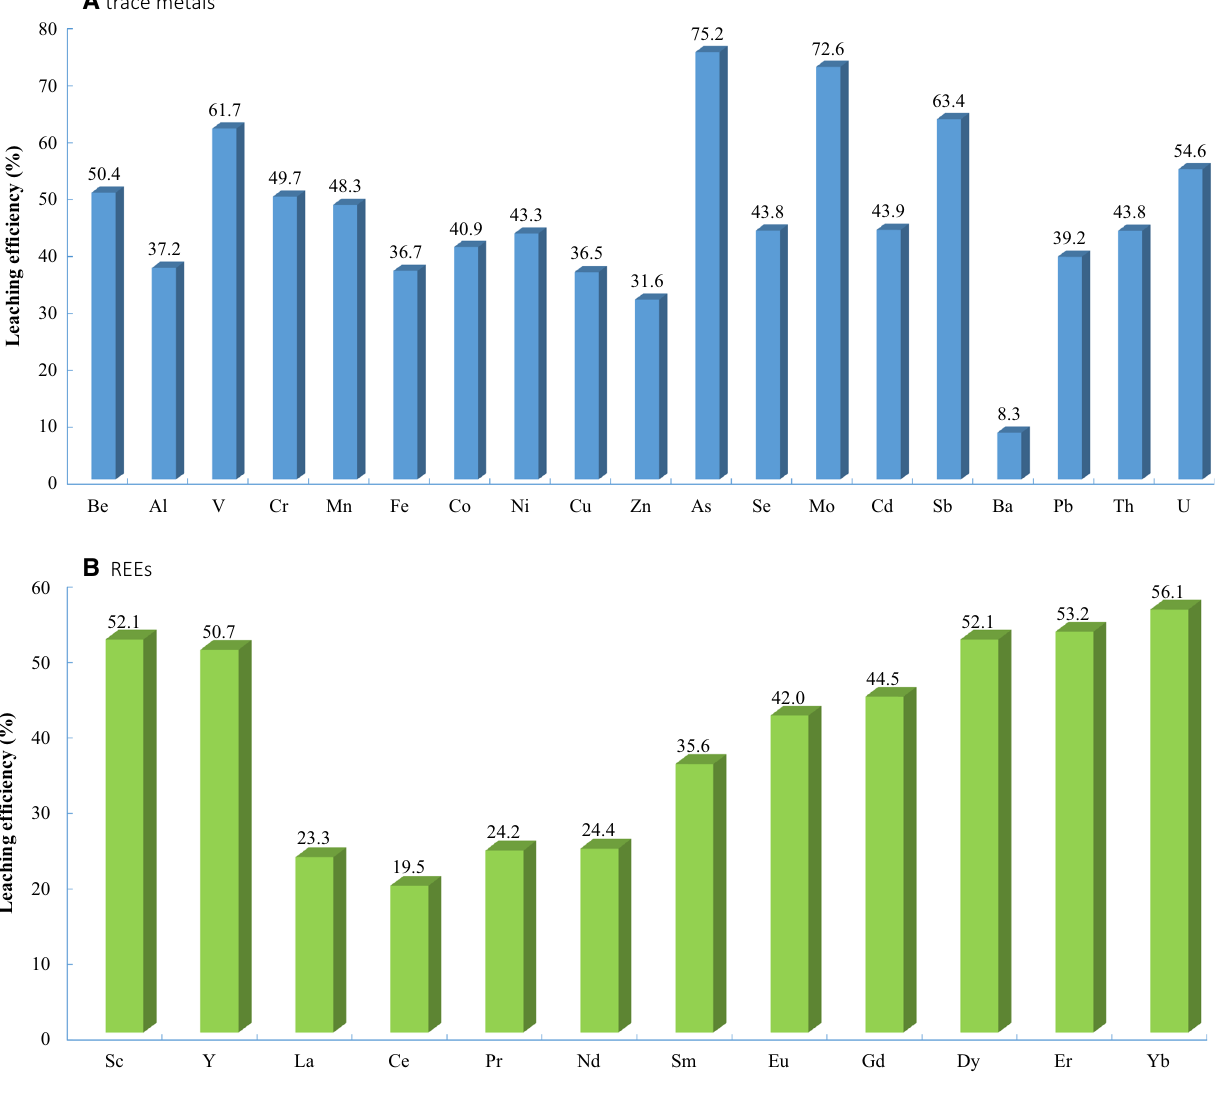
Fig. 5 Leaching efficiency of C. curvatus . a Trace metals; b